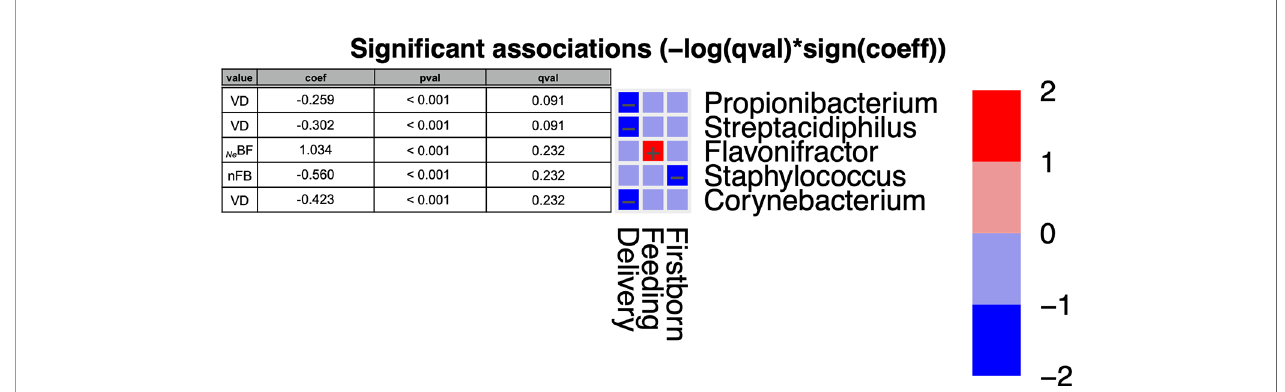
FIGURE 4 | MaAsLin2 signi fi cant results and associations between postnatal factors (delivery, feeding, weaning, and presence of older siblings) and gut microbiota composition at the genus level of infants at six months of age (T2). Based on normalized obtained signi fi cant results, the color scale-bar showed a positive relationship (red) and a negative one (blue) between taxa and factors, ranging from the highest positive normalization (+2) to the lowest one ( −